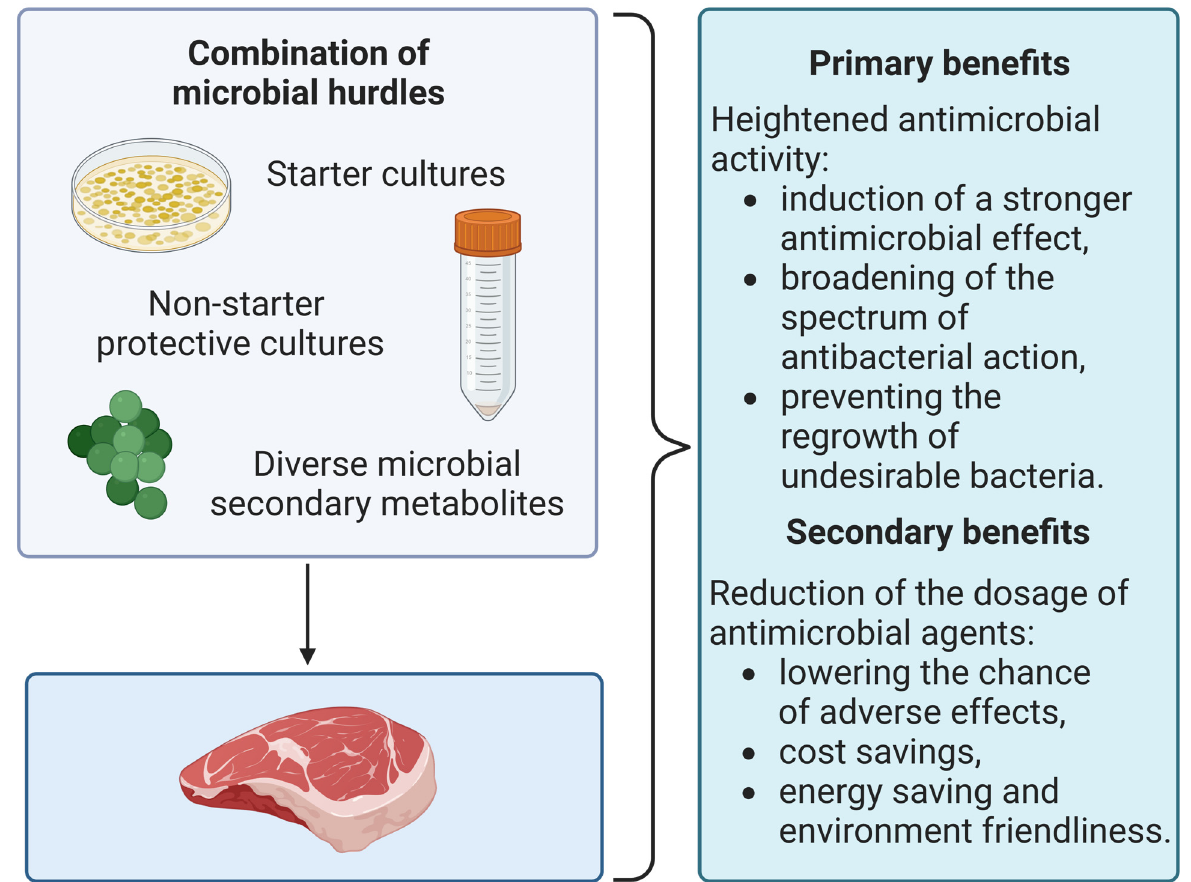
Figure 2. Starter cultures, non-starter protective cultures, or other microbial metabolites can be applied in diverse combinations to meat to gain advantages related mainly to foodborne pathogens and spoilage bacteria inhibition (primary benefit) and lowering the dosage of antimicrobial agents (secondary benefit). Created with BioRender.com (accessed on 27 February 2023).